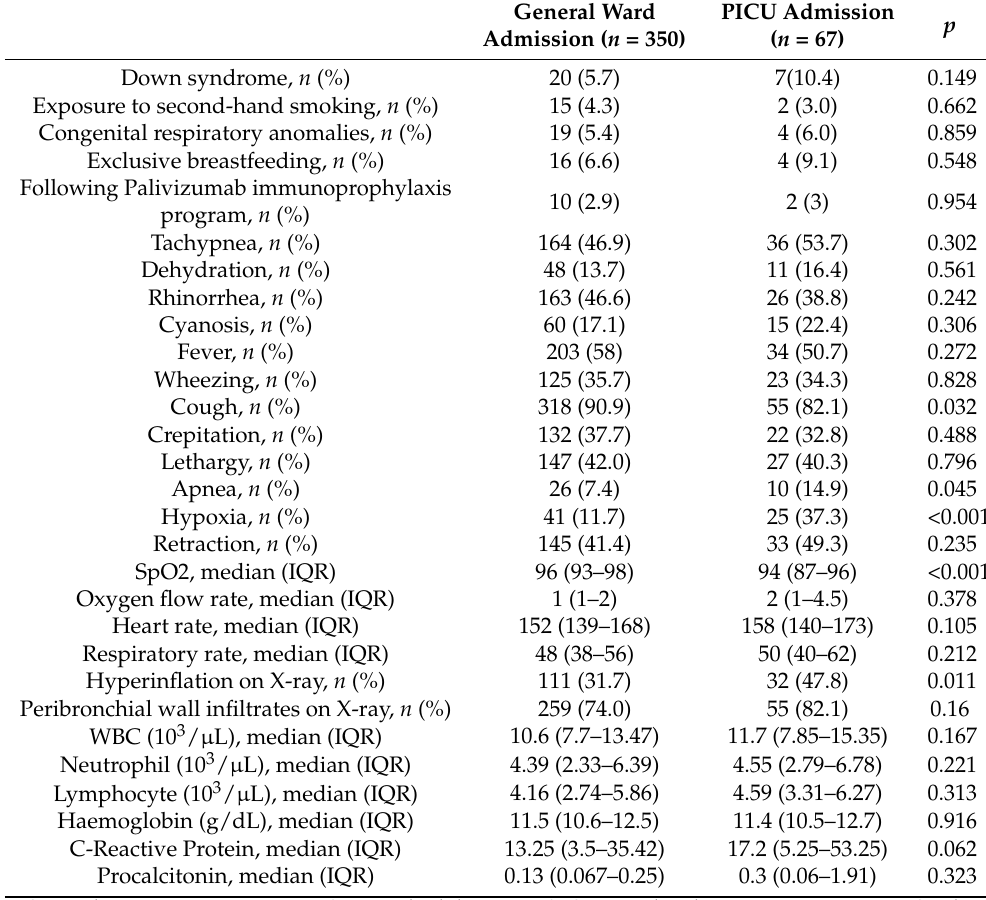
Table 3. Clinical features and lab investigations of patients according to admission